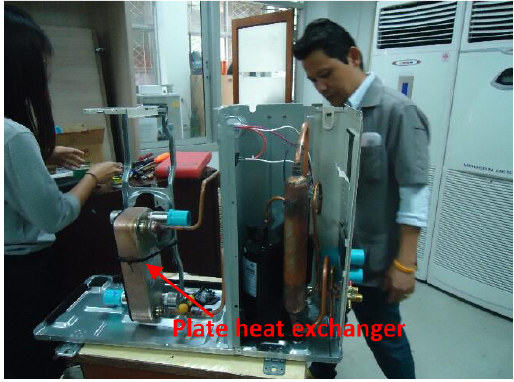
Figure 7. Modification of the air-source heat pump (ASHP) and installation of the plate heat exchanger.